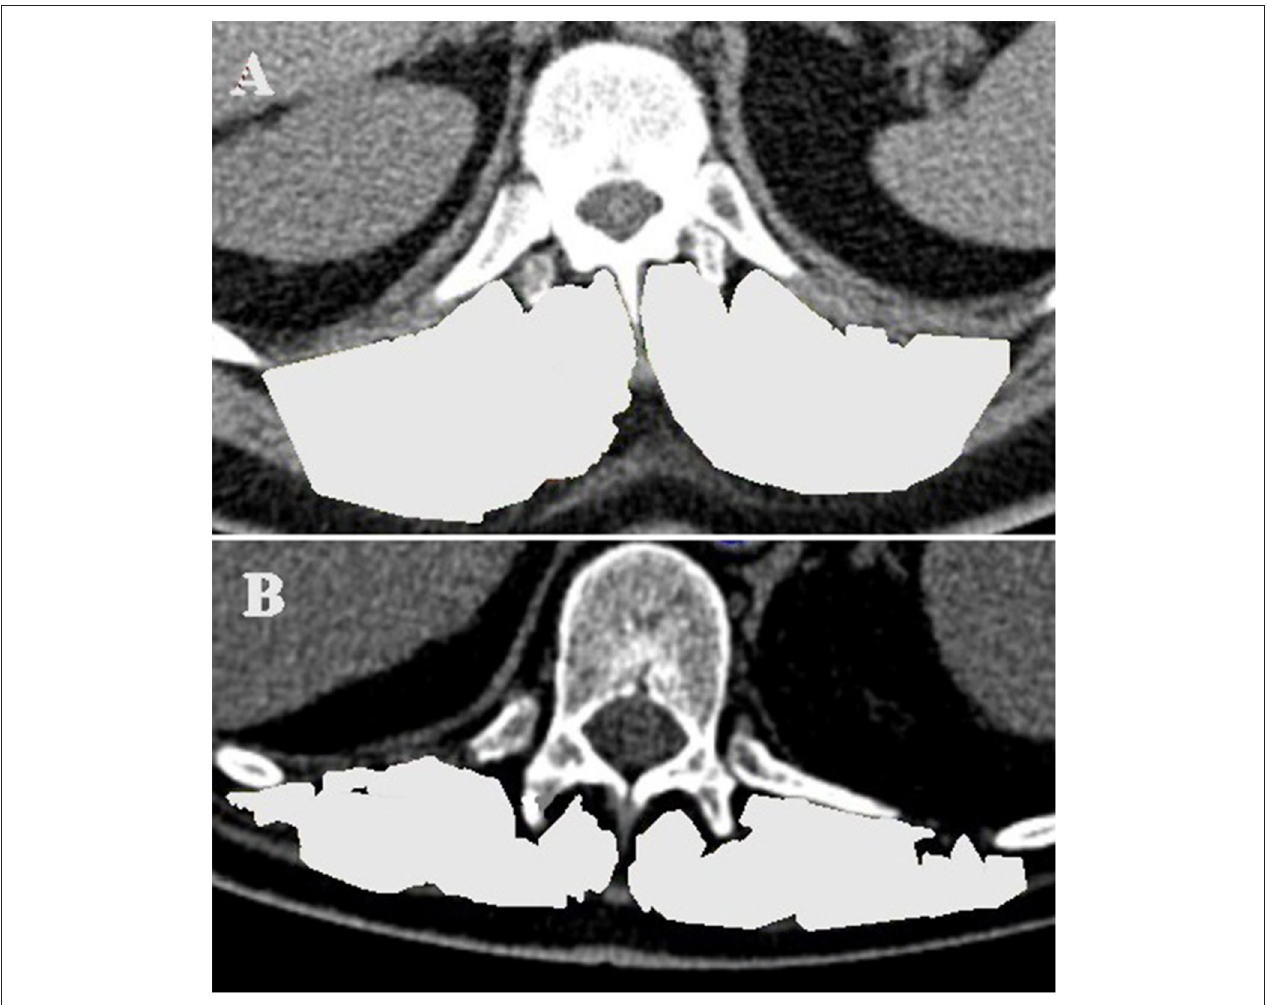
FIGURE 3 | TMESA measurement in an axial CT image at level of the 12th thoracic vertebrae (TMESA area marked in light gray). (A) Male patient without impaired muscle area. (B) Male patient with impaired muscle area. TMESA, total area of the erector spinae muscles; CT, computed